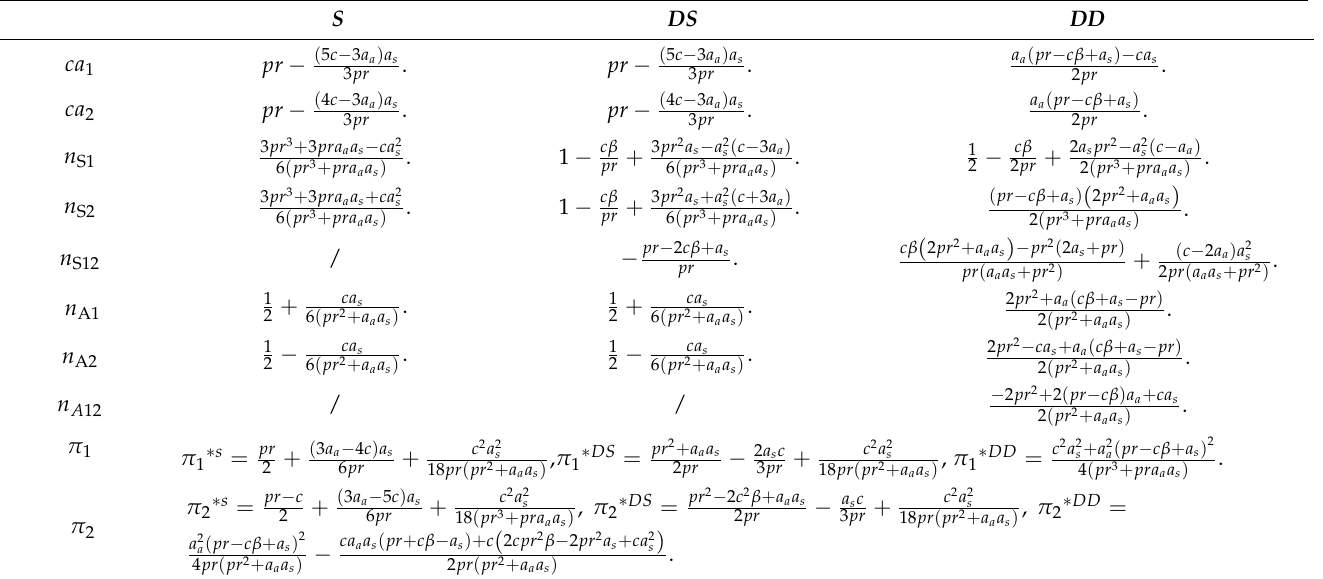
Table 3. The comparison among different